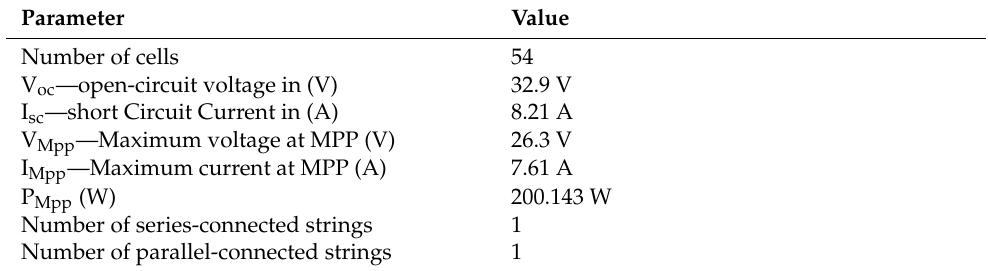
Table 4. Specifications of the solar PV module (KYOCERA solar